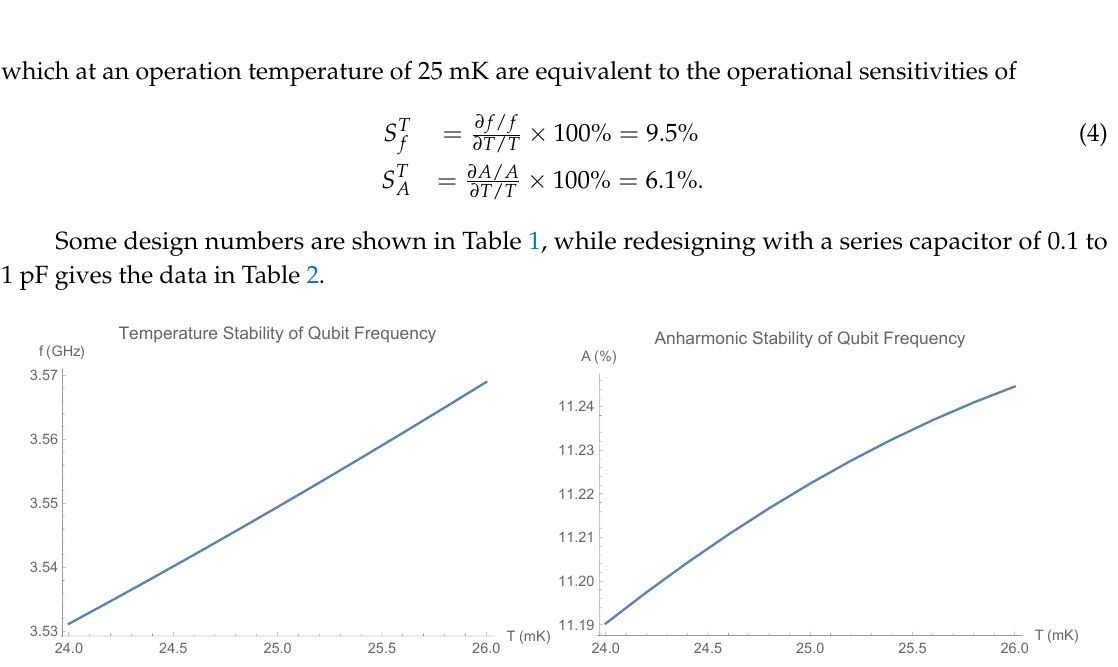
Figure 5. Variations of qubit frequency and anharmonicity versus operation temperature of the dilution fridge.